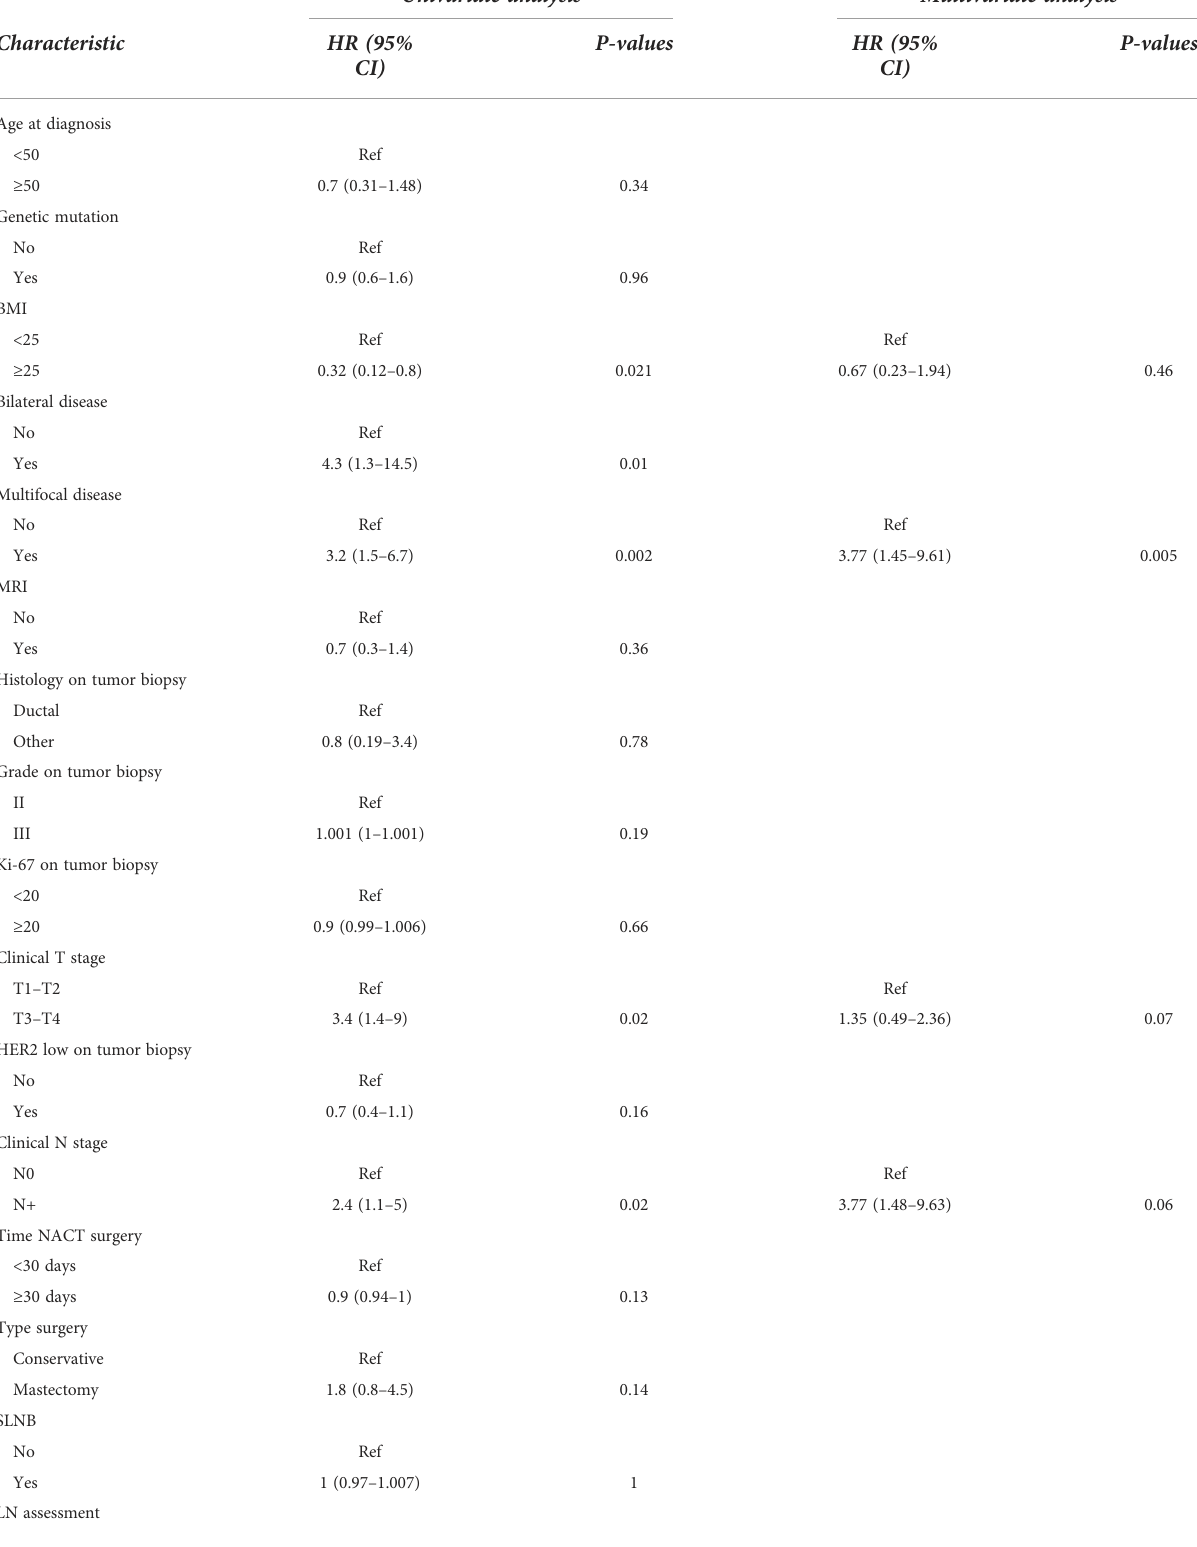
TABLE 3 Univariate and multivariable analyses of EFS in patients not achieving